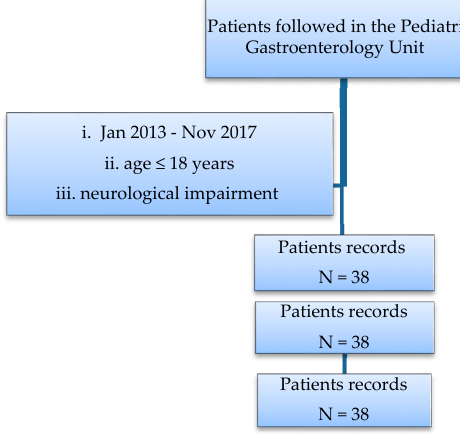
Figure 1. Study flow diagram.